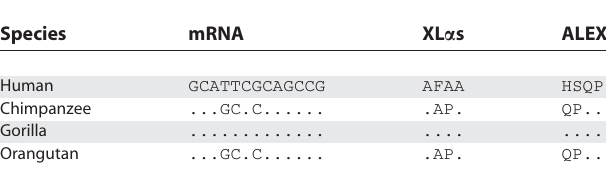
Table 2. An Example of Recurrent Substitutions in Human and Apes Species mRNA XL a s ALEX Human GCATTCGCAGCCG AFAA HSQP Chimpanzee ...GC.C...... .AP. QP.. Gorilla ............. .... .... Orangutan ...GC.C...... .AP. QP.. Dots indicate residues identical to human. Translations of XL a s and ALEX start with the first and the second nucleotides of shown mRNA segment. DOI: